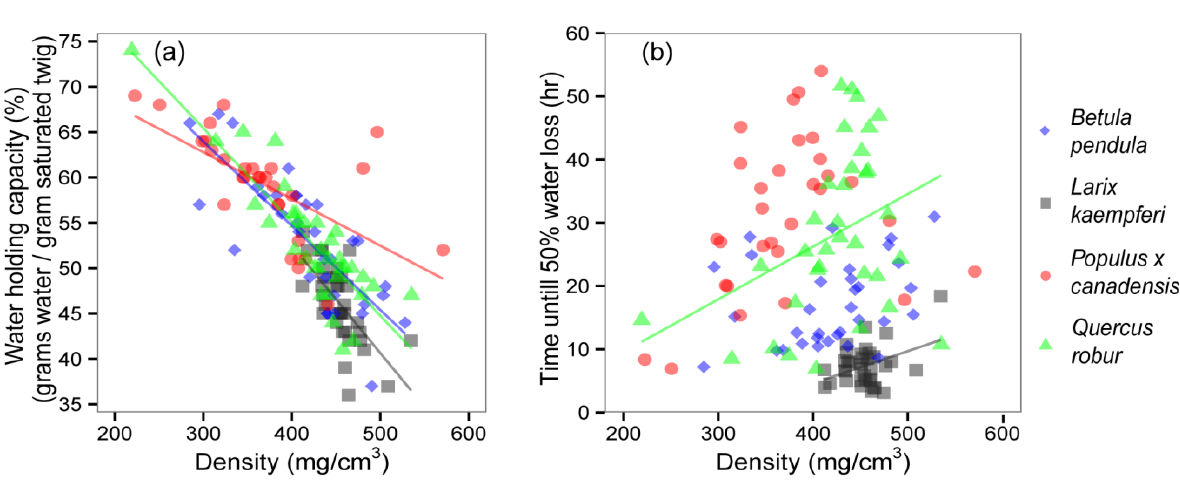
Figure 3. Density versus water holding capacity ( a ) and time until 50% water loss ( b ) of single twigs of all four species; Only significant relationships within species are shown as regression lines (Table 1).